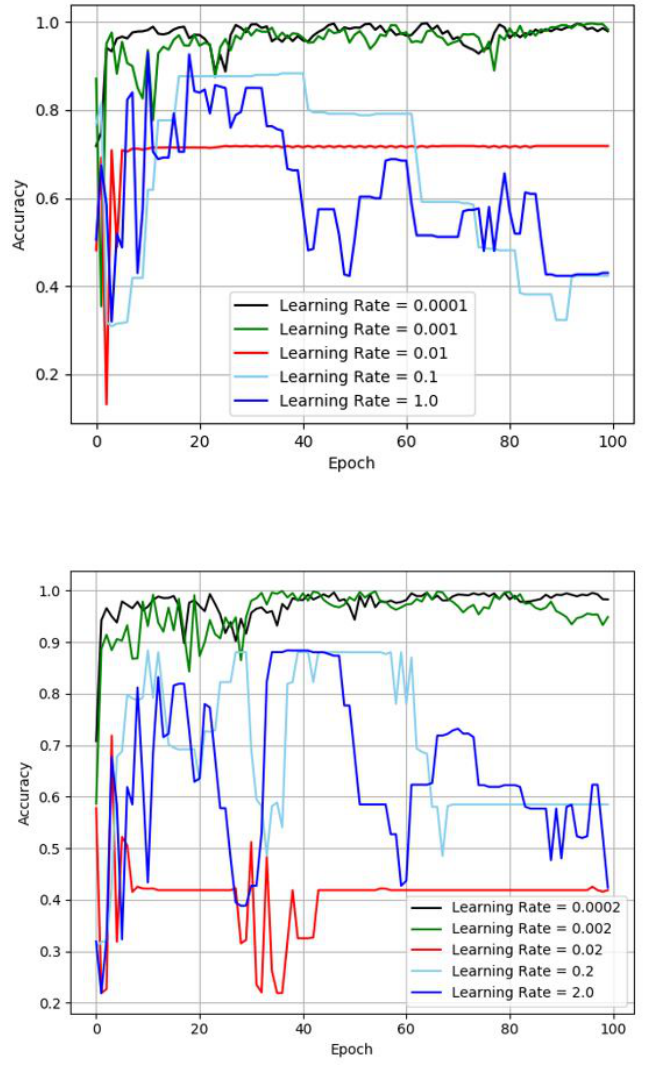
Figure 10. Localization accuracy of training data with different learning